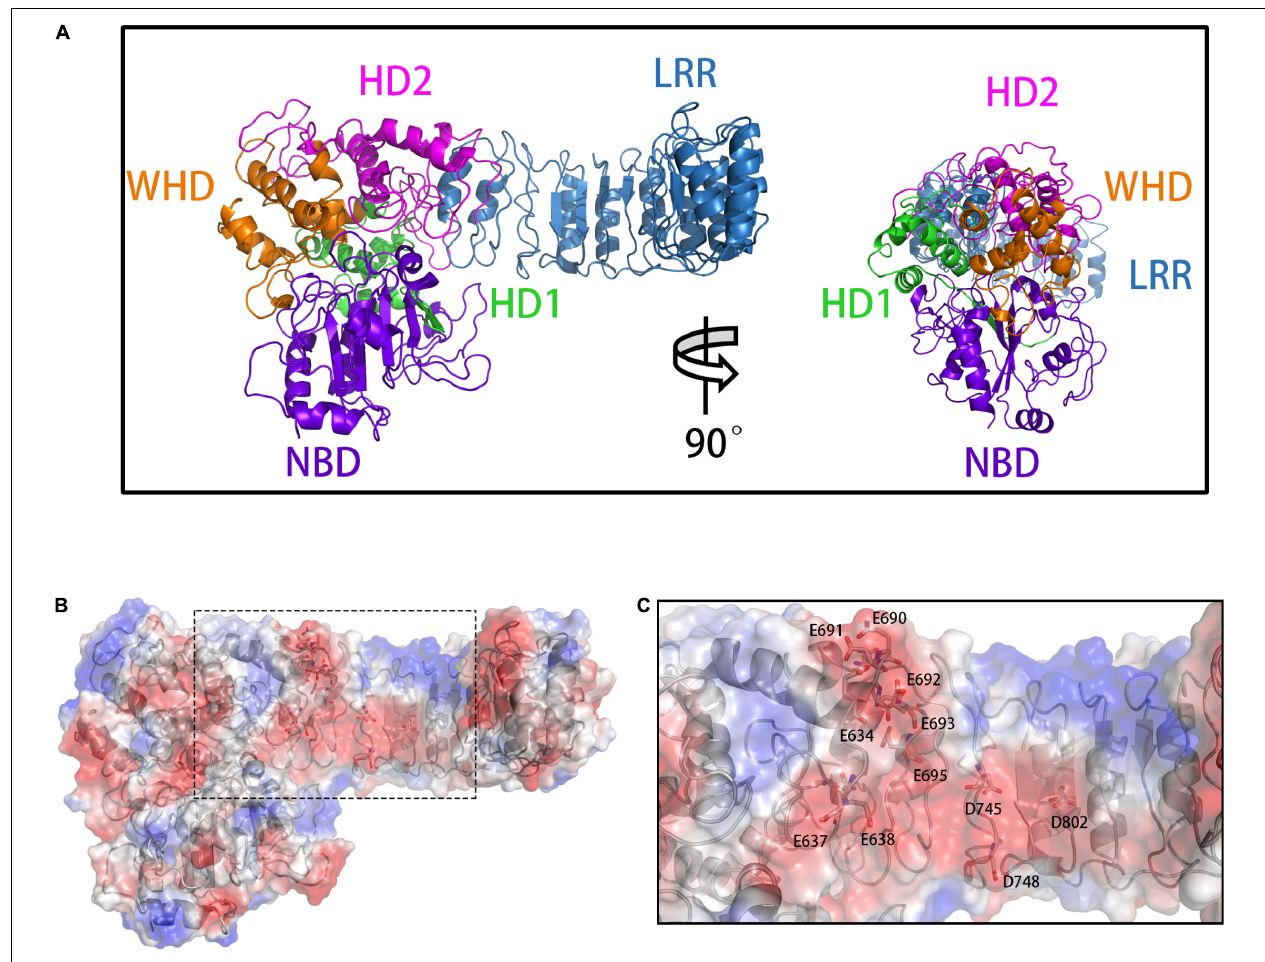
FIGURE 1 | (A) The front (left) and side (right) views of the overall NLRP3 structure. The domains are presented in different colors: NBD (violet), HD1 (green), WHD (orange), HD2 (magenta), and LRR (blue). (B) Calculation of vacuum electrostatics on the surface of NLRP3. The area enclosed in a black rectangle indicate the negatively charged surface of NLRP3. (C) Key glutamate (E) and aspartate (D) residues involved in the formation of the negatively charged NLRP3